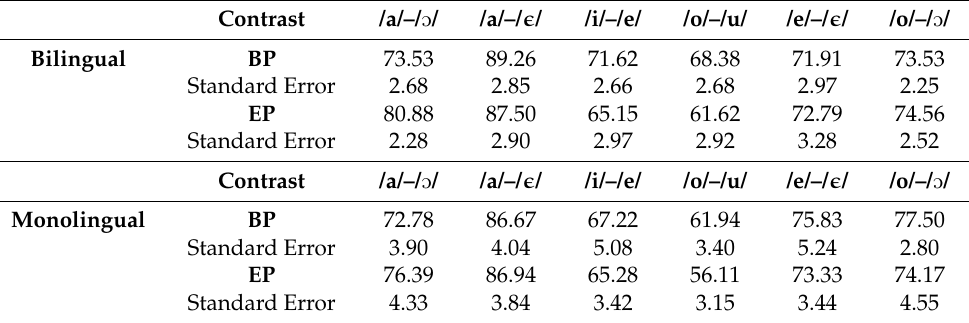
Table 5. Accuracy scores for BP and EP contrasts across language